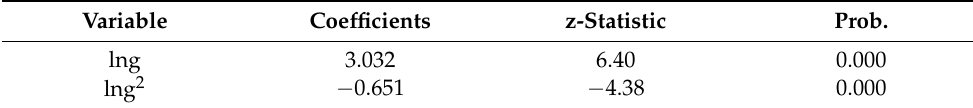
Figure 4. The fitting curve of CO 2 emissions and per capital GDP, 2006 – 2019. Table 7. The regression result of CO 2 emissions and per capital GDP, 2006–2019. Variable Coefficients z-Statistic Prob. lng